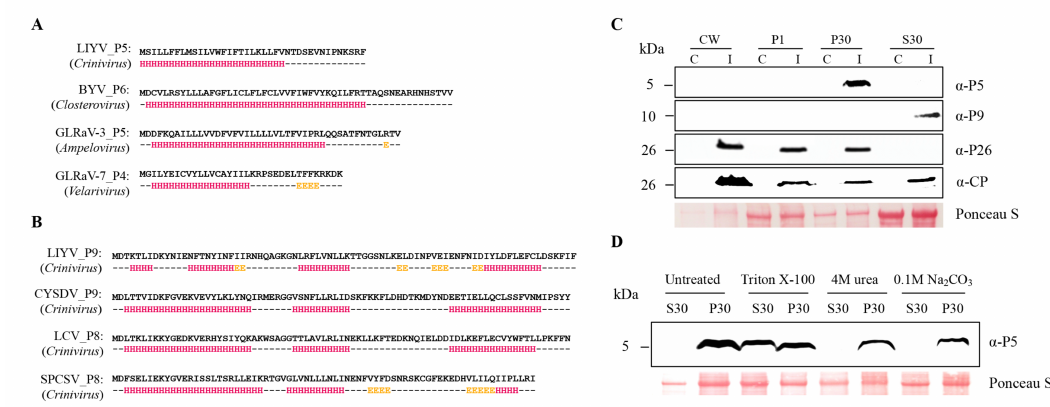
Figure 1. Detection and characterization of Lettuce infectious yellows virus (LIYV) P5 and P9 proteins. Predicted secondary structures of Closterovirus P5 orthologs ( A ) and Crinivirus P9 orthologs ( B ), computed using JPred 4 (http://www.compbio.dundee.ac.uk/jpred/). Residue positions predicted to participate in alpha helix formation are highlighted in red, positions predicted to participate in beta sheet structures are highlighted in yellow. Amino acid sequences used for secondary structure predictions were translated from sequences obtained from NCBI: LIYV RNA2 (NC_003618), Beet yellows virus (BYV, NC_001598), Grapevine leafroll-associated virus -3 (GLRaV-3, GQ352633), Grapevine leafroll-associated virus -7 (GLRaV-7, NC_016436), Cucurbit yellow stunting disorder virus (CYSDV RNA2, NC_004810), Lettuce chlorosis virus (LCV RNA2, NC_012910), Sweet potato chlorotic stunt virus (SPCSV RNA2, KC888962). ( C ) Cellular fractionation of P5 and P9 detected from LIYV-infected Nicotiana benthamiana plants. Four fractions, cell wall (CW), 1000 × g pellet (P1), 30,000 × g